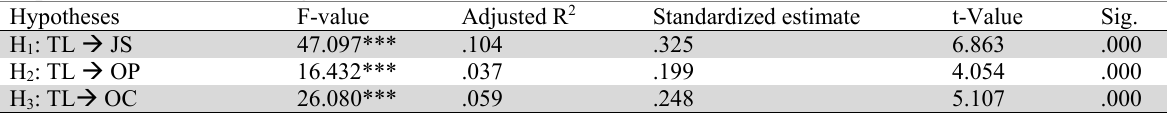
Empirical results: linear